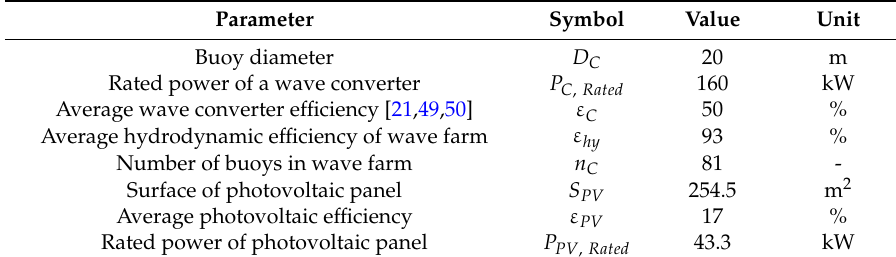
Table 3. Main parameters of sea wave–solar energy farms.